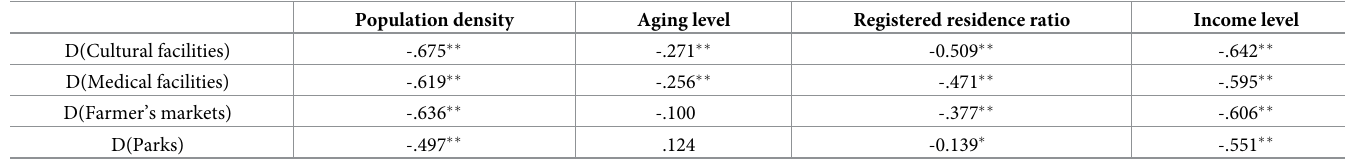
Table 4. Pearson correlation coefficient between the shortest walking distance to facilities and community